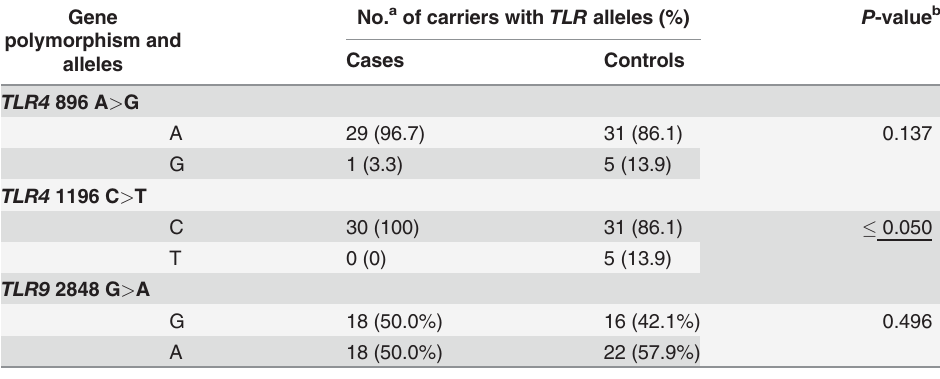
Table 4. Distribution of the alleles, located at TLR4 and TLR9 polymorphic sites. Gene polymorphism and alleles